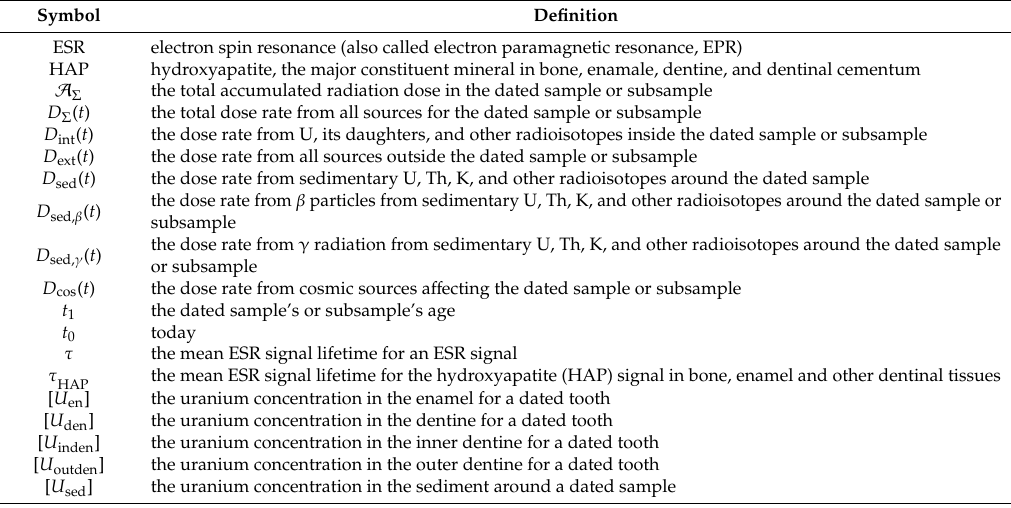
Table A1. ESR symbols and